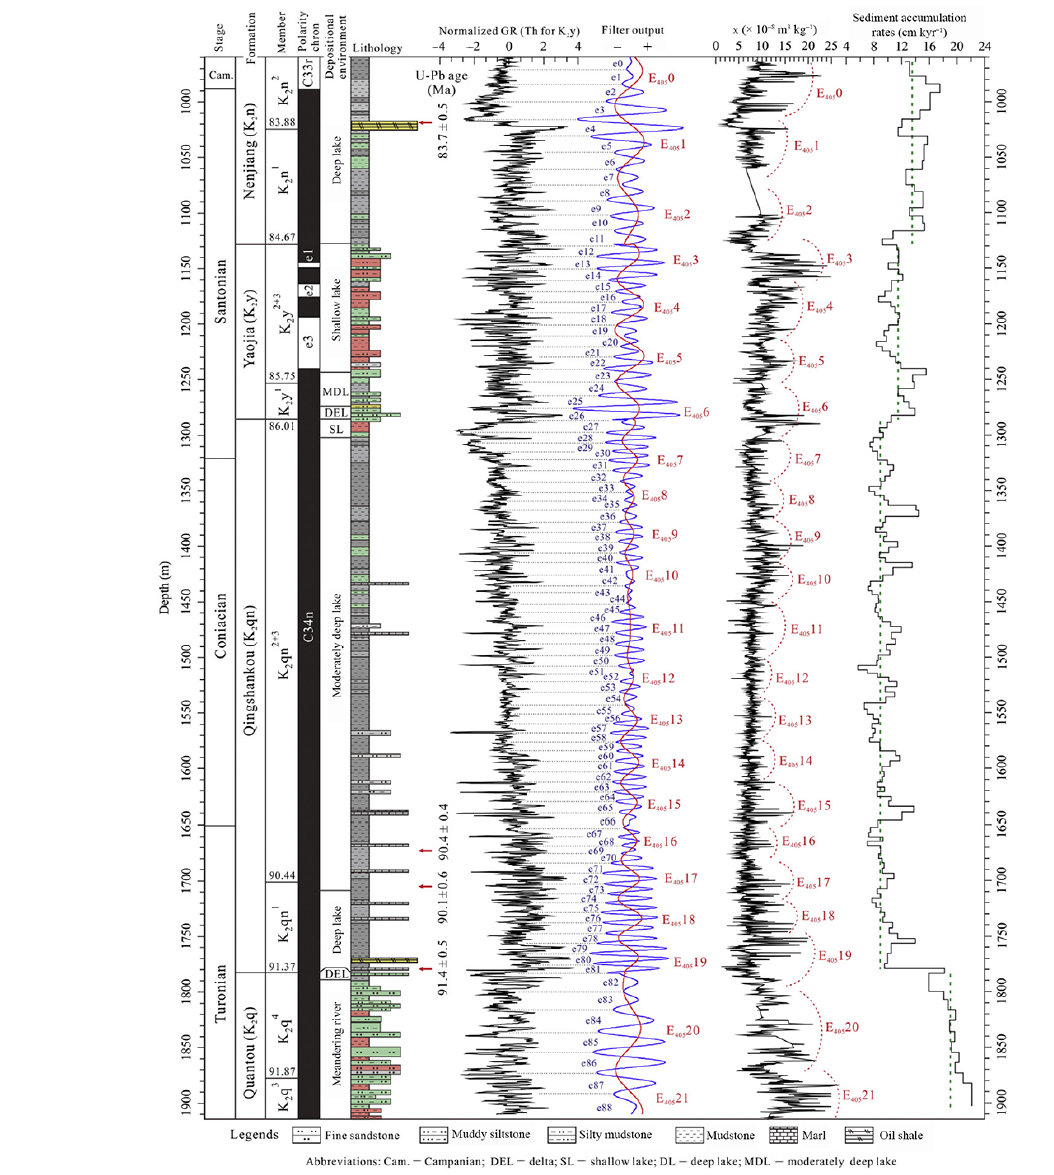
Figure 20. Cyclostratigraphic interpretation and sedimentary accumulation rates of the SK-1 south core in the Songliao Basin (Wang et al., 2013b). The numbers at the member column are the astronomical timescale ages in “Ma” for the strata boundaries. The “e” (blue) and “E” (red) represent 100kyr short and 405kyr long eccentricity cycles,